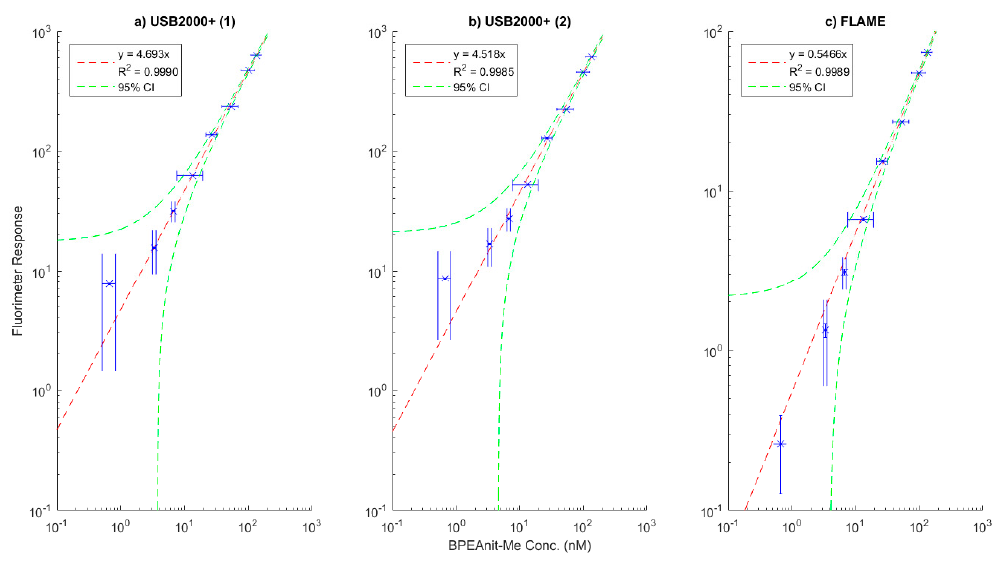
Figure 3. ( a–c ) The calibration plots for the three flow-through fluorimeters constructed and tested. ( a ) and ( b ) use USB2000 + series spectrometers, whilst ( c ) uses a newer FLAME spectrometer with temperature stabilization. The flame spectrometer is more adept at measuring very low concentrations, although these are far below those measured when integrated into the Particle Into Nitroxide Quencher (PINQ).